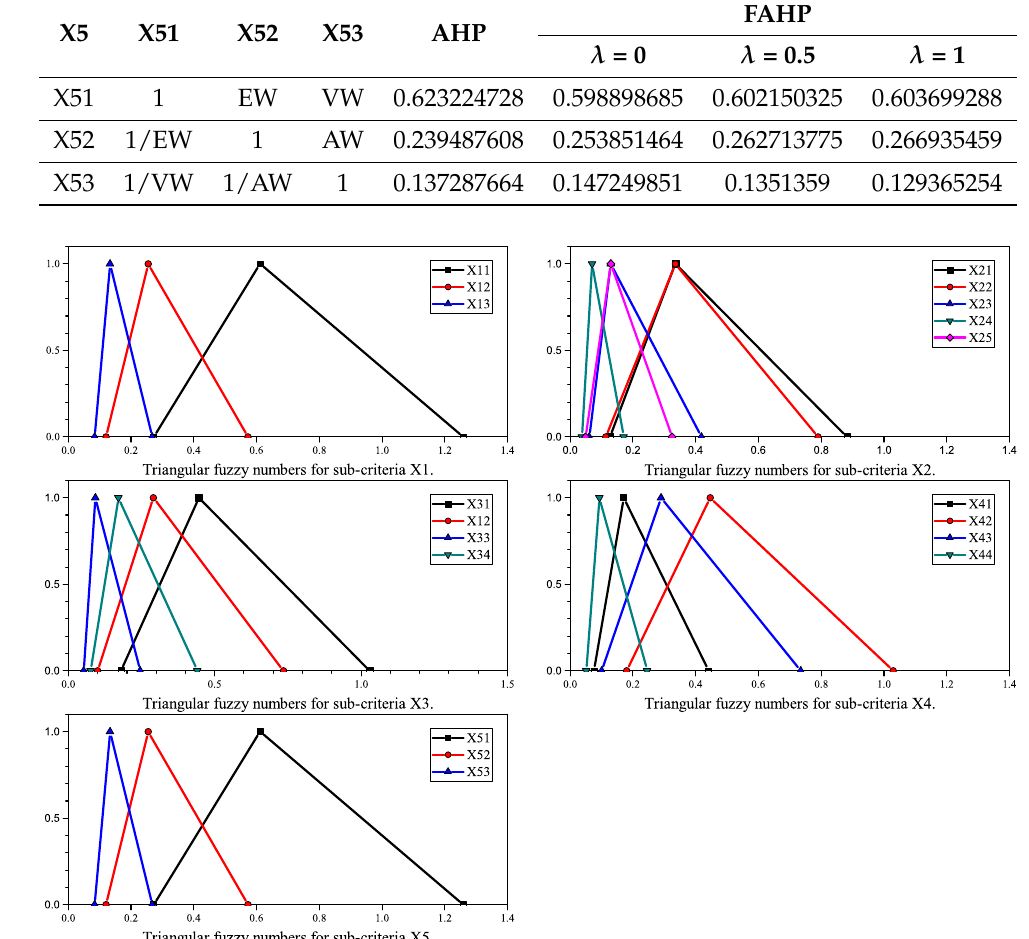
Figure 5. Triangular fuzzy numbers for criteria